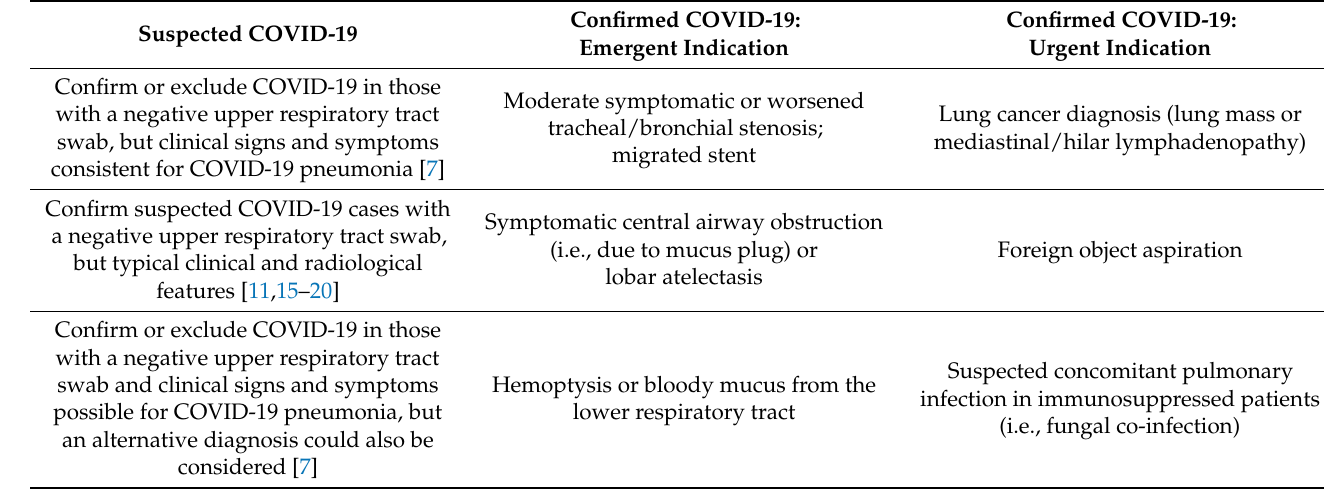
Table 1. Indications for bronchoscopy in suspected COVID-19 and indication for urgent or emergent in confirmed COVID-19 during the pandemic